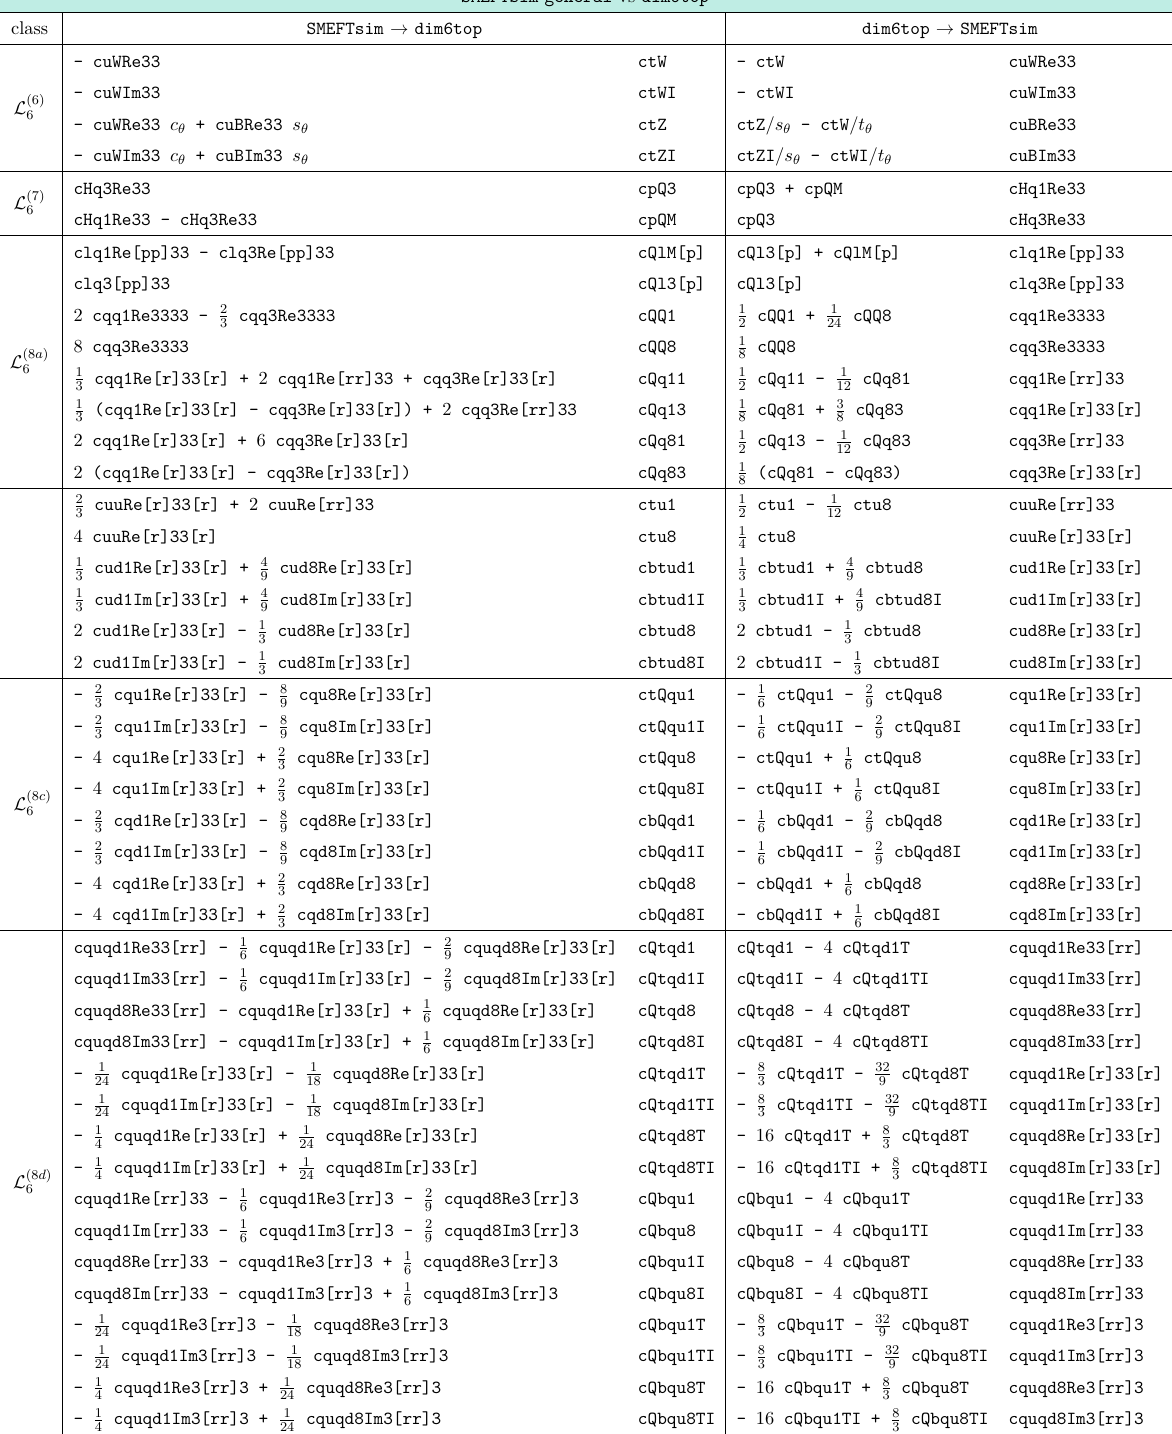
Table 27 . Conversion table between the SMEFT parameters defined in the general version of SMEFTsim and in dim6top : parameters that require a basis rotation. Lepton flavor indices p take values in { 1,2,3 } . Quark flavor indices r take values in { 1,2 }